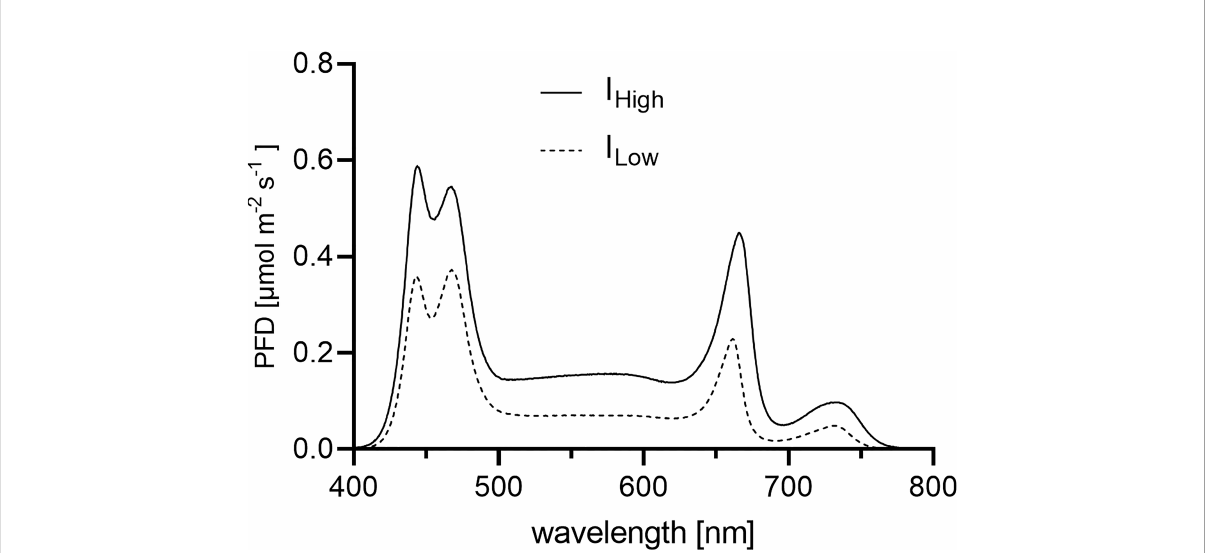
FIGURE 2 White broad-band LED light spectra applied during the experiments. Depicted are the LED light spectra as PFD s (photon fl ux densities) [µmol m - 2 s -1 ] per wavelength [nm] between 400 and 780 nm. Each LED light spectrum (I Low light treatment = dashed line; I High light treatment = solid line) represents the average PFDs per wavelength obtained from 120 measurements across the entire experimental block (1.2 m 2